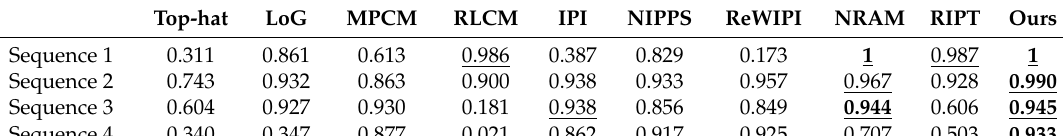
Table 6. Area under curve (AUC) values of the 10 methods.